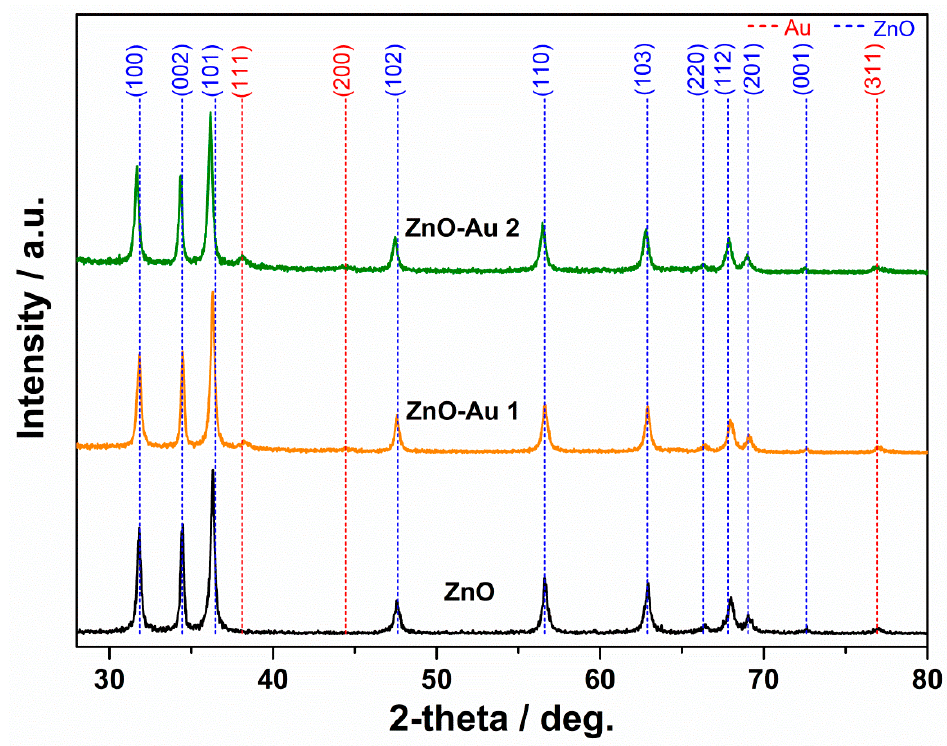
Figure 2. X-ray diffraction data characteristics of the ZnO nanoparticles and the ZnO-Au nanocomposites. Figure 2. X-ray di ff raction data characteristics of the ZnO nanoparticles and the ZnO-Au nano- composites.